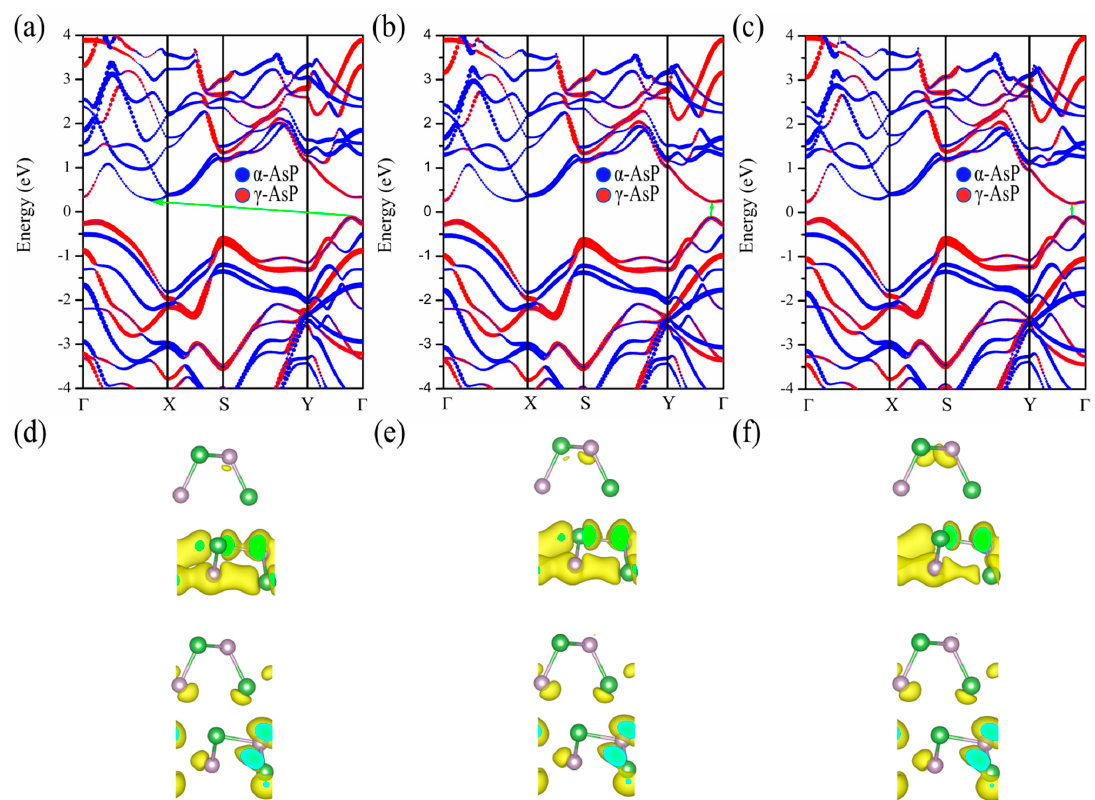
Figure 6. Computed band structures of the α -AsP/ γ -AsP homojunction under the applied strain along x of ( a ) 2%, ( b ) 3%, and ( c ) 4%. The corresponding charge density of the CBM and VBM is shown in ( d – f ), respectively. The value of the isosurface is 1 × 10 − 3 e/Å 3 .